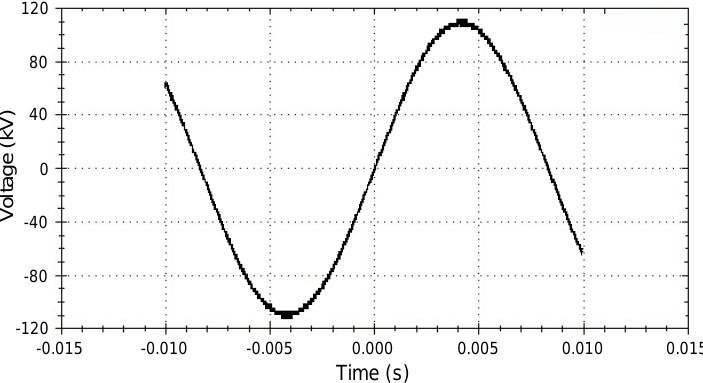
Figure 14. Application of RMS 79.8 kV to the bushing.